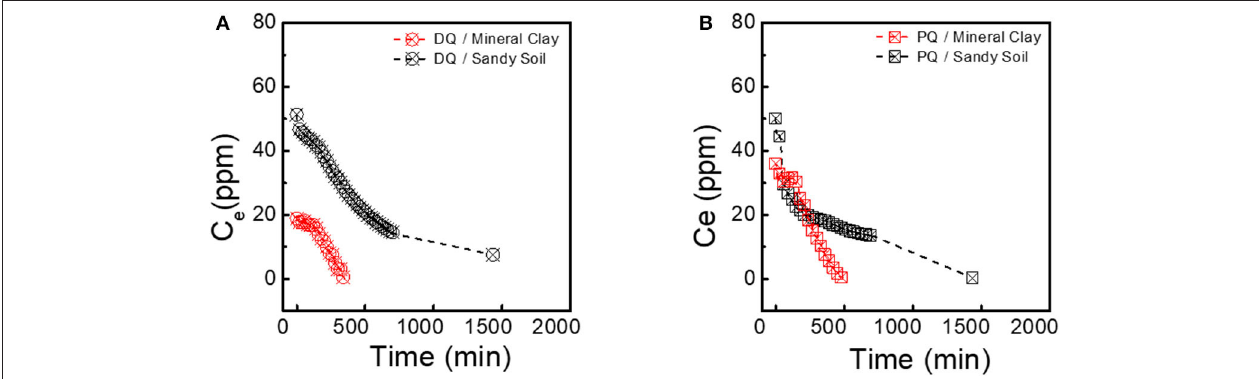
FIGURE 4 | Representative adsorption kinetics of: (A) electrolyte supplemented with DQ, and in (B) electrolyte supplemented with PQ onto mineral clay medium and sandy